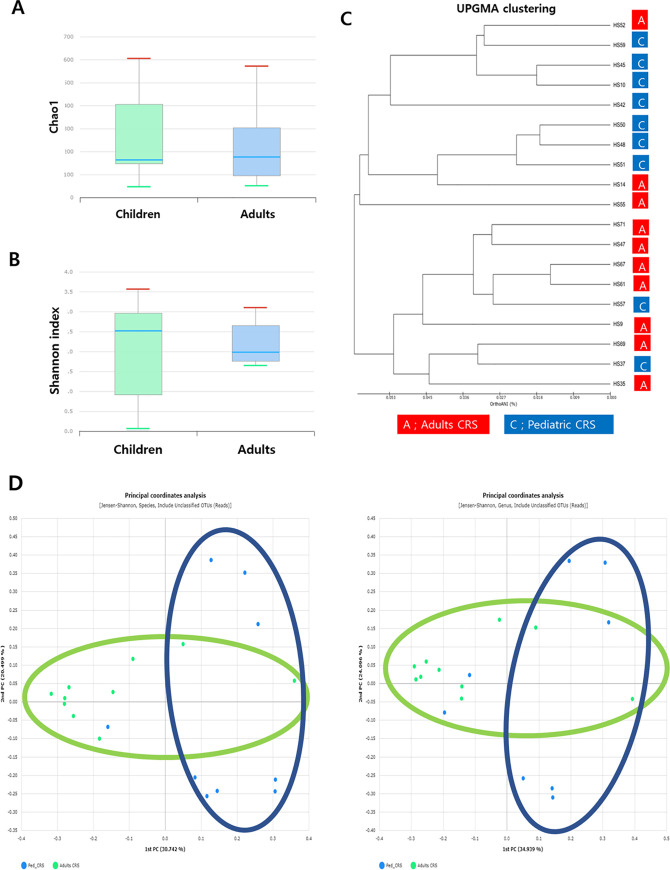
A box plot of the alpha diversity indices in the adult and pediatric CRS groups.(A) Chao1 richness values, (B) Shannon diversity indices. Overall microbial alpha diversity did not differ significantly between the two groups. (C) UPGMA clustering of microbiome taxonomic profiles in both groups using the UniFrac distance, showing a relative clear separation between the two groups. (D) Principal coordinate analysis (PCoA) plots showed two principal coordinates that explained the clear distance between samples.